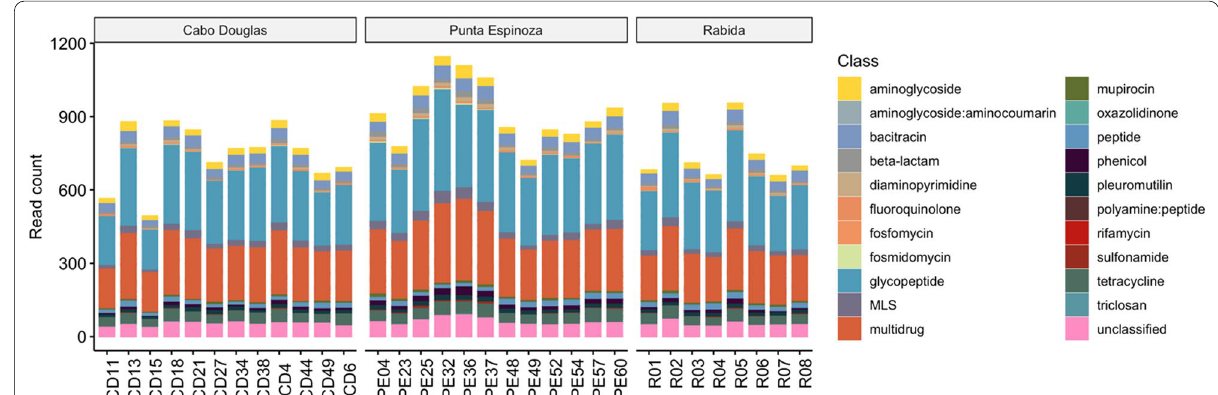
Fig. 7 Gut resistome composition of the Galapagos marine iguanas. The abundance is shown as number of reads in assembled contigs